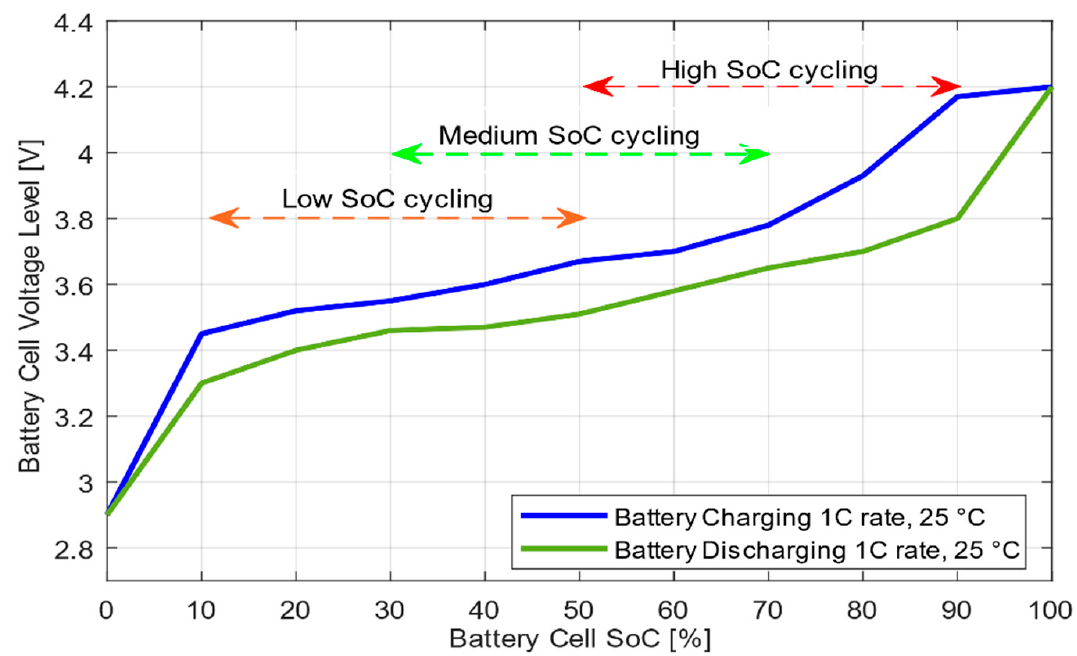
Figure 7. Charging and discharging curve of the lithium nickel manganese cobalt (NMC) battery